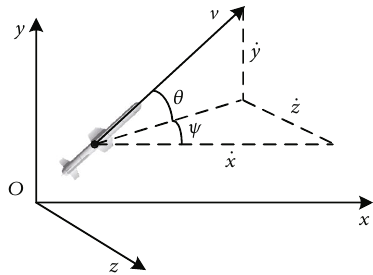
Figure 1: Movement of the interceptor or the target in the inertial coordinate